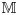
Emergence of cooperation over time.The figure illustrates the fraction of cooperative nodes against the rounds or time steps: low homophily (A) and high homophily (B). The figure shows the evolutionary dynamics of the PD game played between the interacting nodes in a multiplex network with M = 3 layers. In both cases N = 1000 nodes. The results are obtained choosing a fixed number of simulations and the colour corresponds to the density: ‘red’ indicates the highest density (that is the maximum number of overlapping points), while ‘blue’ means the lowest density. As can be observed, increasing the homophily value of the multiplex network M, we note a faster emergence of cooperation.